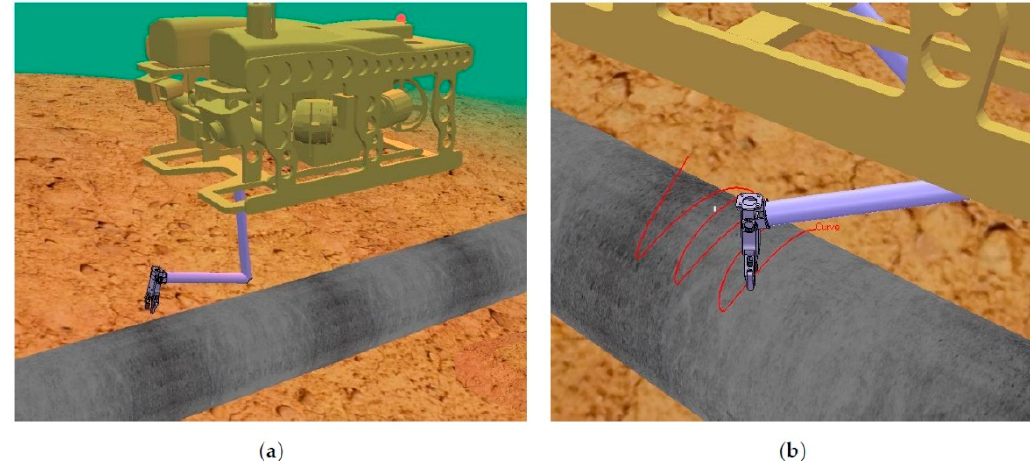
Figure 7. Interface for controlling the formation of motion trajectories of the MM working tool. To visualize the MM motions over the surface of work objects, the data (generalized coordinates of MM, and linear and angular displacements of the UUV relative to the initial point of its stabilized positioning) obtained during the simulation of the complex dynamic model of the UUV with MM were sent from Matlab/Simulink back to V-REP by the UDP protocol. The results of the visualization of the actual technological manipulative opera- tion performed are shown in Figure 8a and Figure 8b.